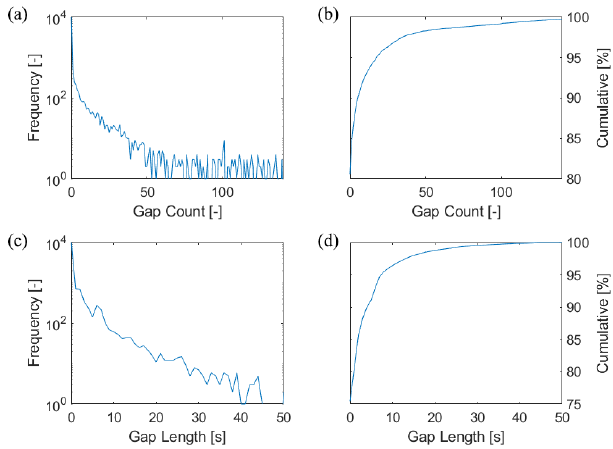
Figure 1. Frequency distribution of temperature gaps in the strato- spheric height section between 20 and 25km, based on 13667 RS41 profiles, years 2014–2019. (a) Frequency distribution of the number of data gaps (independent of gap length). (c) Frequency distribution of the length of the largest gap identified in a profile. Panels (b) and (d) show the corresponding cumulative